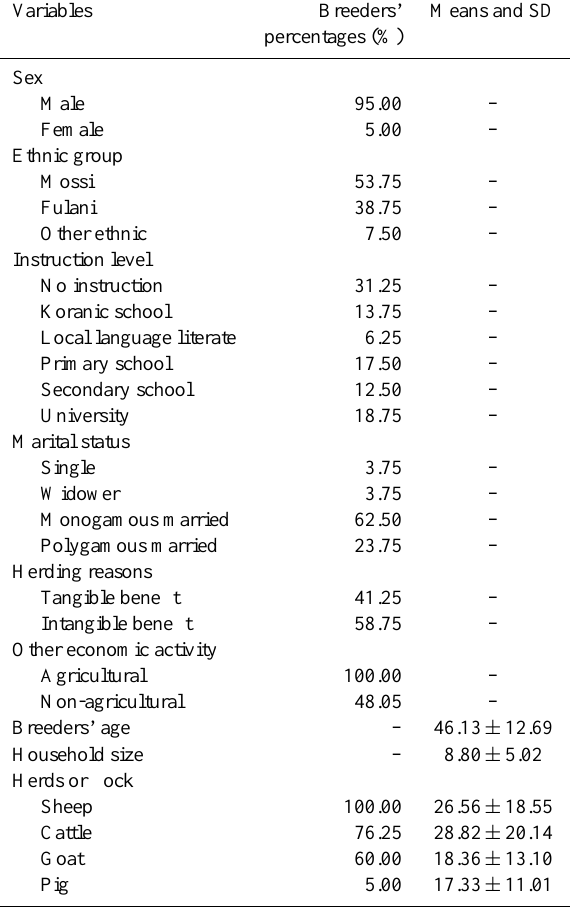
Table 2. Socio-economic characteristics.